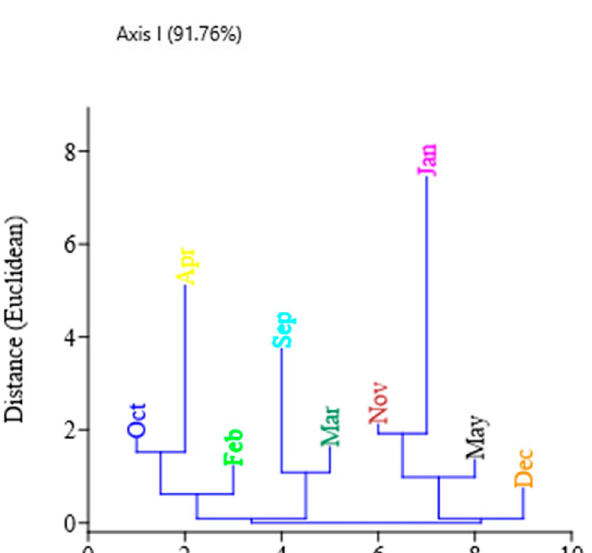
Fig. 4 Pollution load index (PLI) variations in different months in the Indus River Estuary. Dotted red colour line added to highlight baseline values Fig. 5 Hierarchal cluster based on Euclidean distance established for different months in this